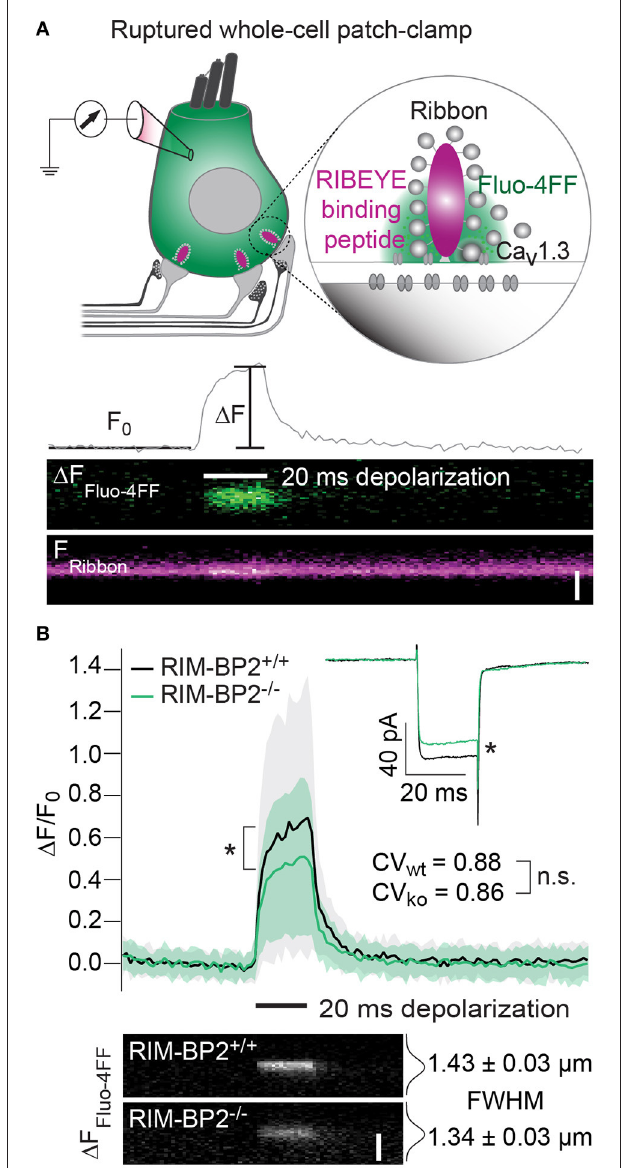
FIGURE 4 | RIM-BP2 promotes the abundance of synaptic Ca 2 + -channels in IHCs. (A) Top: Illustration of the confocal Ca 2 + -imaging experimental design. IHCs were loaded with a fluorescently conjugated dimeric RIBEYE-binding peptide (10 µ M) to visualize synaptic ribbons at the AZ, and a low affinity Ca 2 + -indicator Fluo-4FF (400 µ M) to monitor synaptic Ca 2 + -influx. Bottom: Example line scan of a fluorescently labeled ribbon (F ribbon ) and Fluo-4FF fluorescence change ( 1 F Fluo − 4FF ) at an individual IHC AZ during 20ms depolarization (black bar) and temporal profile of Fluo-4FF fluorescence at the center of the ribbon. 1 F Fluo − 4FF from line-scans was normalized to their baseline fluorescence F 0 hence 1 F/F 0 . Scale bar: 2 µ m. (B) Top: Average temporal profile of synaptic Ca 2 + -signals ( 1 F/F 0 ) for RIM-BP2 + / + ( n = 41, N = 14, black line) and RIM-BP2 − / − ( n = 42, N = 13, green line) AZs during IHC depolarizations (black bar). 1 F/F 0 and its corresponding I Ca were significantly reduced in RIM-BP2 − / − IHCs (Wilcoxon rank test, both p = 0.01). 1 F/F 0 data represent IHC grand averages, mean ± SD (shaded area). The coefficient of variation (CV) represents synapse heterogeneity and was